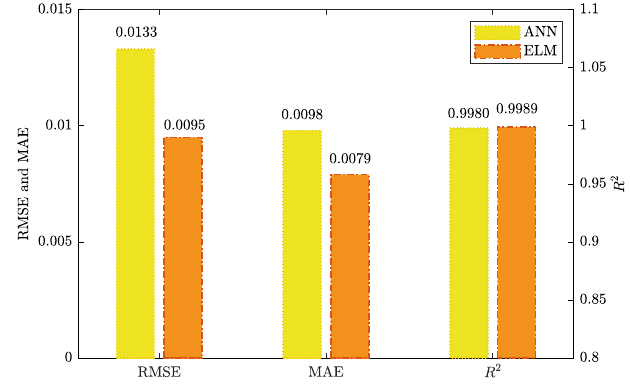
Figure 9. The performance comparison of prediction using ANN and ELM.